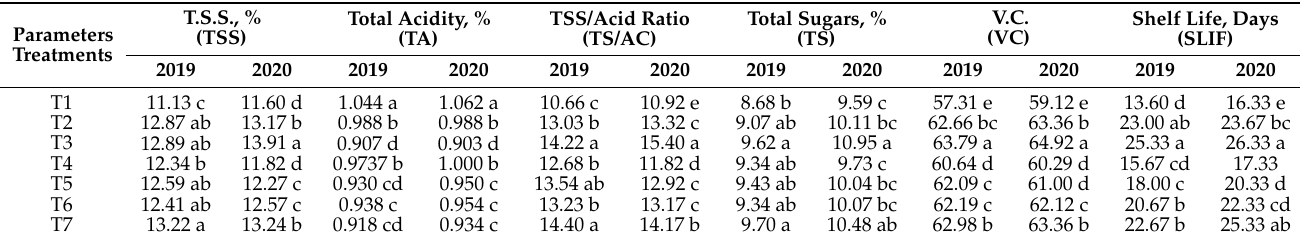
Table 7. Influence of iron (nano, sulfate, and chelated) foliar spray on some fruit chemical properties and shelf life of Washington navel orange trees during 2019 and 2020 experimental seasons. Parameters